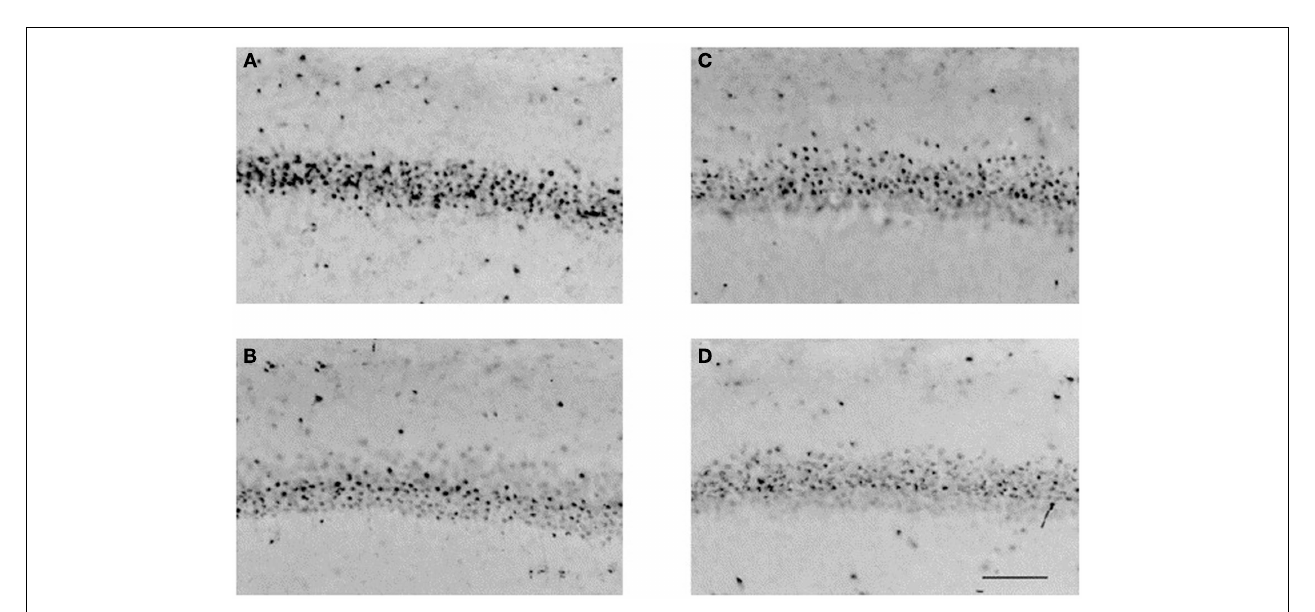
neurons in the CA1 region of the hippocampus in (A) sham males, (B) males + muscimol, (C) sham females, and (D) females + muscimol. Musciol treated rats have fewer neurons in the CA1 region of the hippocampus than their sham counterparts. Scale bar = 100 µ m. Reprinted from Nunez et al. (2003), with permission from